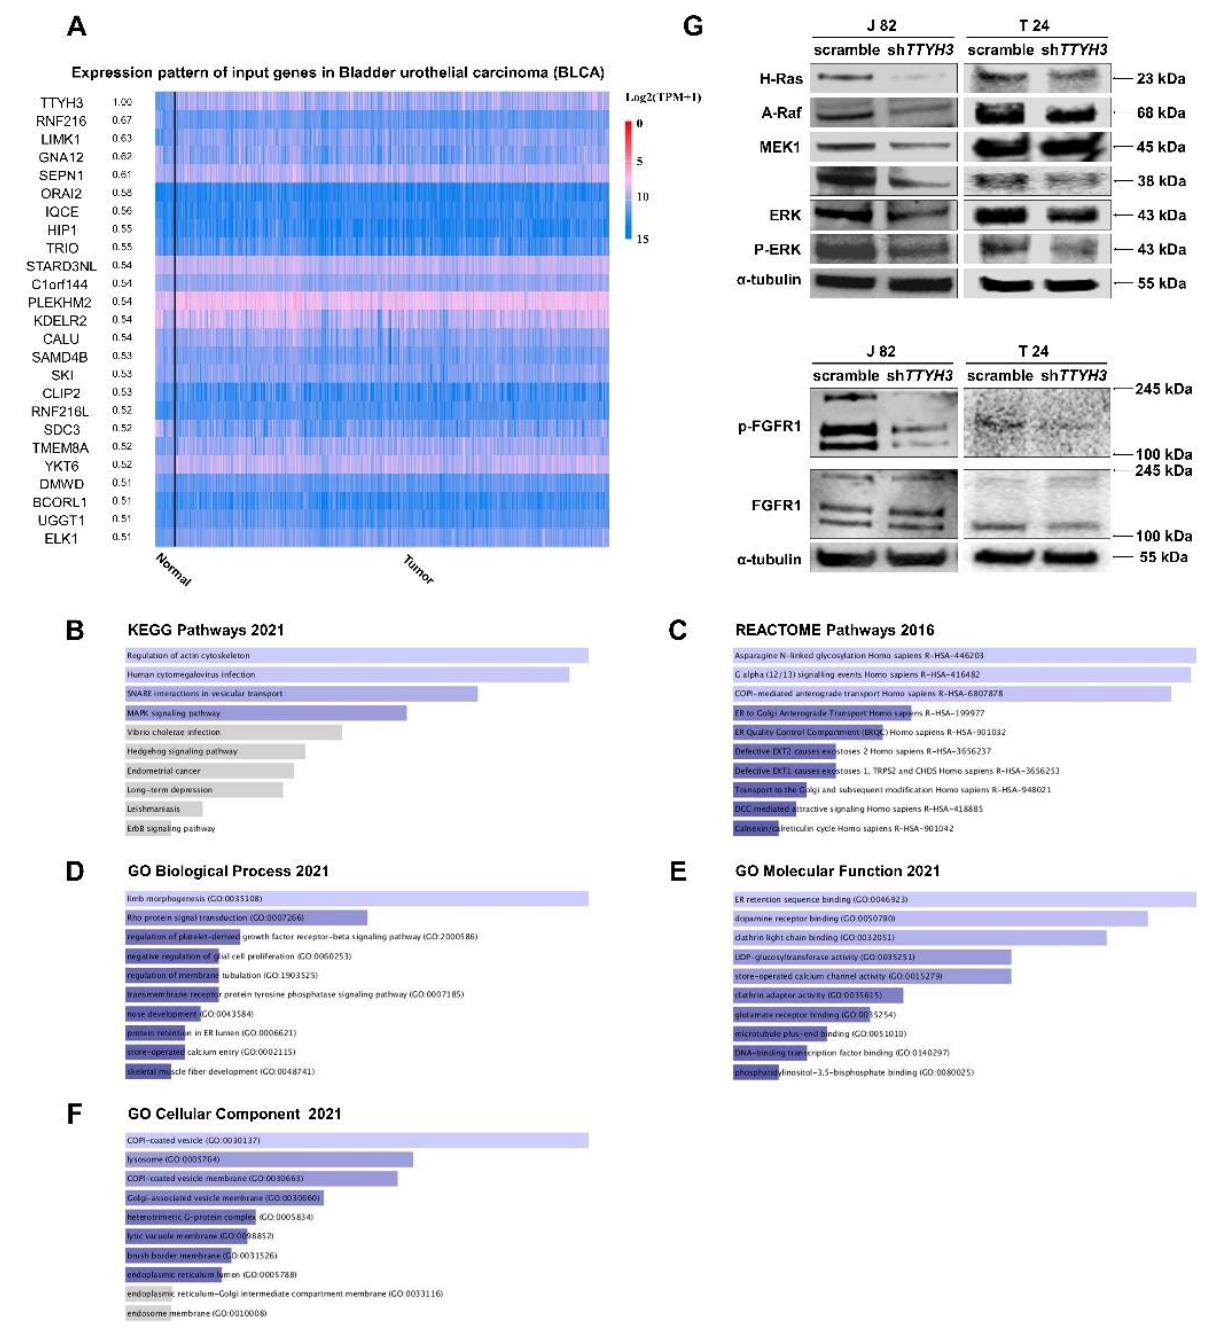
Figure 3. Genes co-expressed with TTYH3 and related pathways in bladder cancer. ( A ) UALCAN analysis of the profile of genes co-expressed with TTYH3 . ( B – F ) Profiles of genes co-expressed with TTYH3 involved in signaling pathways in bladder urothelial carcinoma (BLCA). This figure depicts the results showing the gene ontology (GO) and signaling pathways of TTYH3 , and the positively correlated genes in bladder cancer. The bar graphs represent genes positively correlated to TTYH3 , showing the involvement in BLCA in pathway analysis performed using Enricher. The bar graph represents the ratio of the percent composition of terms in proteomic data vs. percent composition in the genome annotation. The length of the bar represents the significance of that specific gene-set or term. ( G ) Western blot analysis of mitogen-activated protein kinase (MAPK) signaling and FGFR1 proteins in TTYH3 -knockdown bladder cancer cell lines. α -tubulin expression was used as the control.